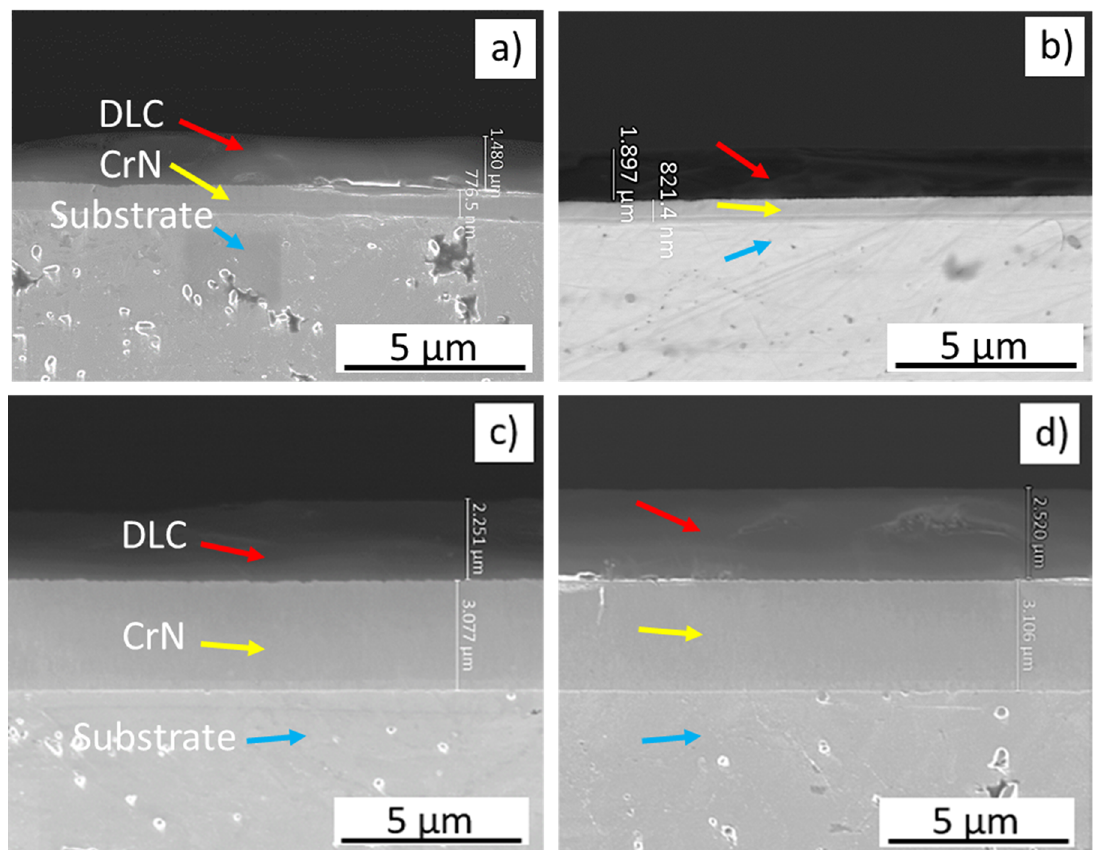
Figure 1. SEM images of the cross sections of the coated samples, a) and b) DLC-1, c) and d) DLC-2. Red, yellow and blue arrows indicate DLC coating, CrN chromium nitride interlayer and the PNC- plasma nitrocarburized substrate,